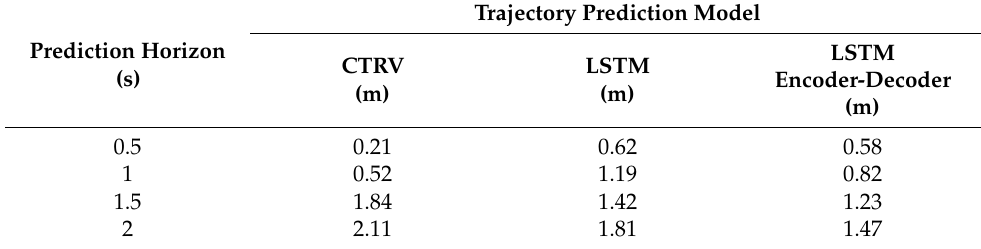
Figure 17. Comparison of trajectory prediction models: ( a ) deceleration and lane-keeping; ( b ) acceleration and lane-keeping; ( c ) acceleration and lane-changing. Table 3. Trajectory prediction accuracy